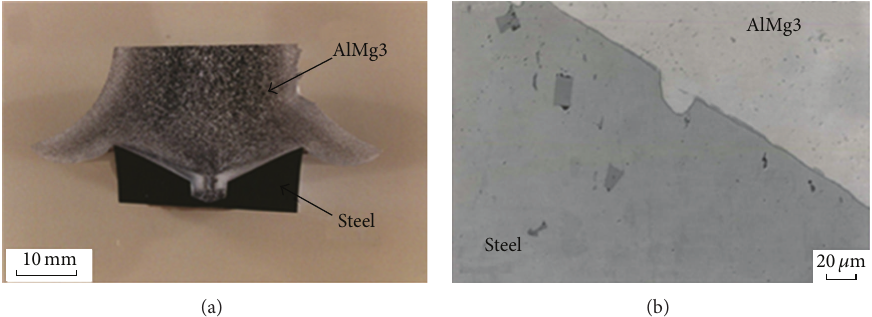
Figure 10: The macrostructure of the friction welded AlMg3 aluminium alloy-X10CrNiTi189 austenitic steel joint, with a diameter of 30 mm and a conical shape of the joint (a) and the microstructure of such joint